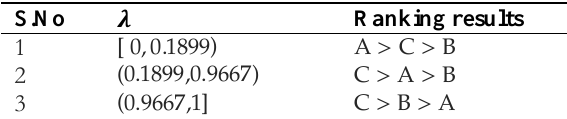
Table 3. Ranking of IFN’s for values of